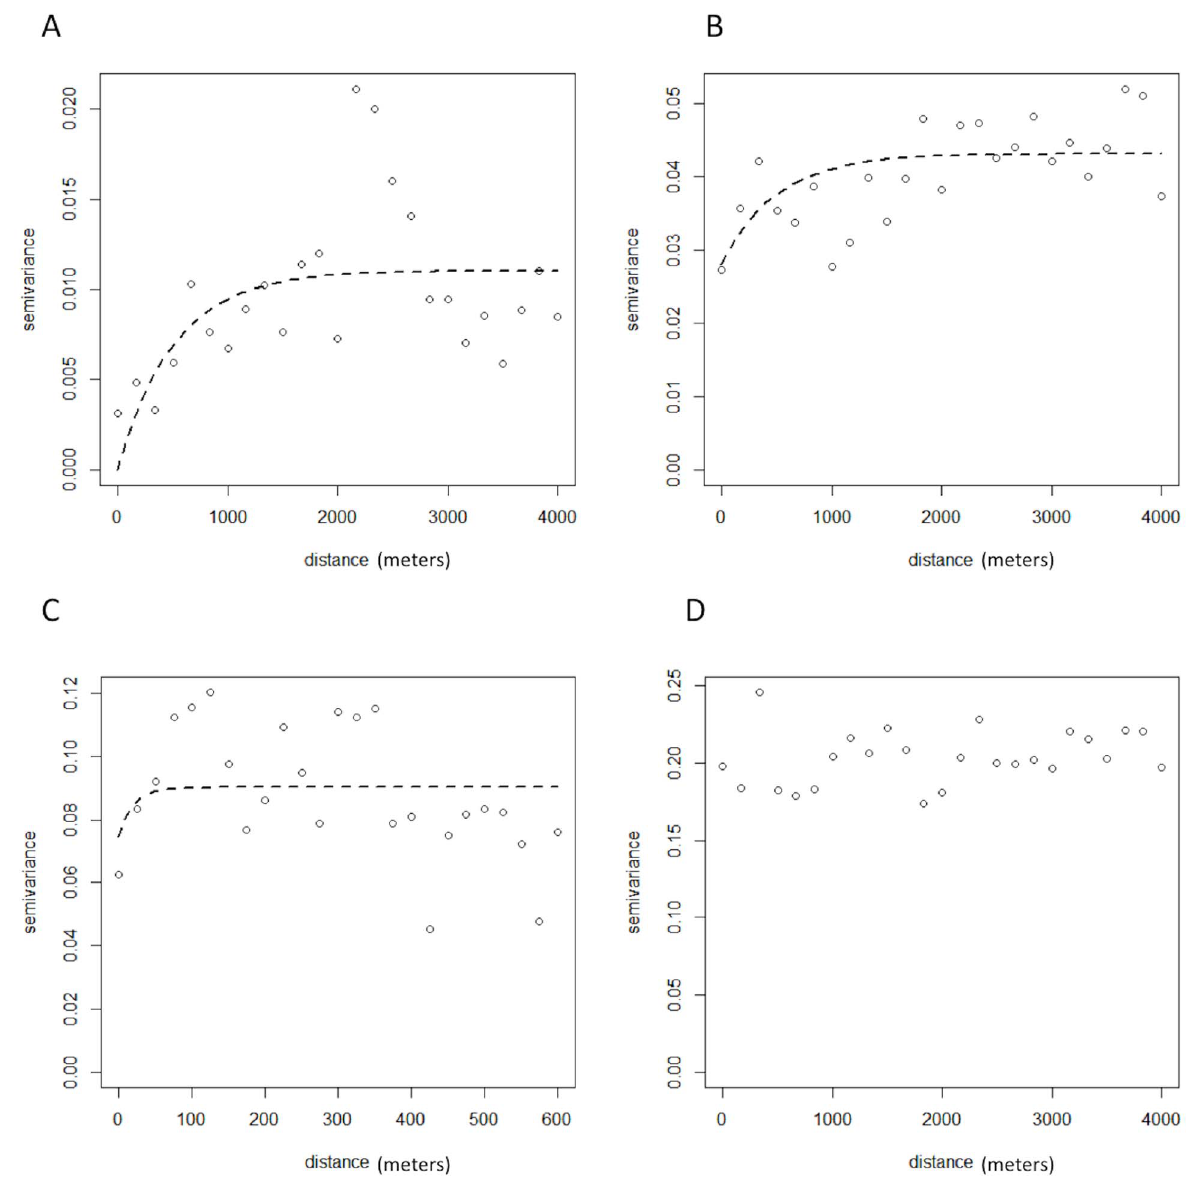
Figure 7. Semivariograms of spatial dependence of antigen and antibodies: A. Og4C3 . 128 units, B. Og4C3 . 32 units, C. Wb123 positive, D. Bm14 positive.